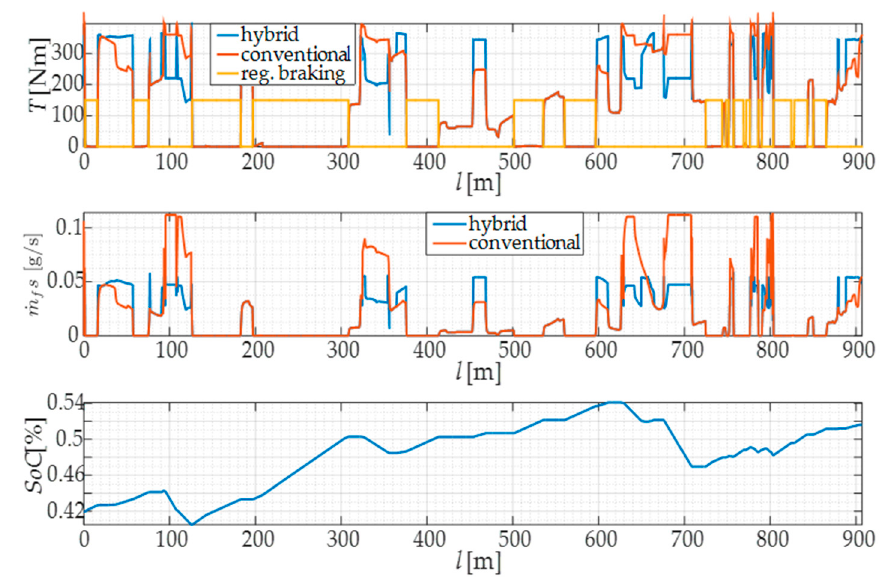
Figure 14. Time diagrams of hybrid vs. conventional vehicles.